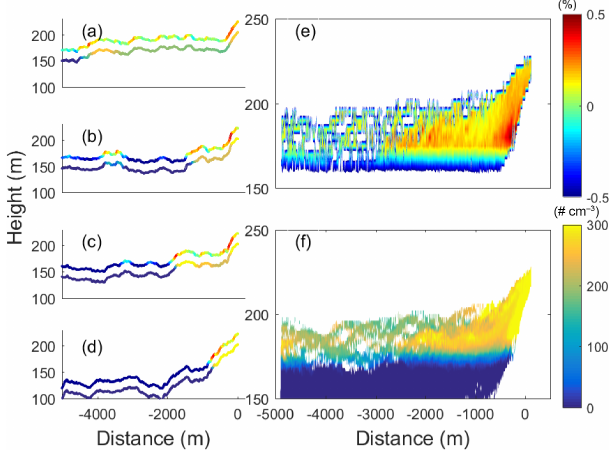
Figure 5. (a–d) Selected trajectories with supersaturation and CDNC superimposed. The two curves in each plot show the same trajectory, but are offset in y direction for easier distinction. The up- per curve shows the correct height. (e) Average supersaturation over all simulated trajectories. (f) Average CDNC over all simulated tra-